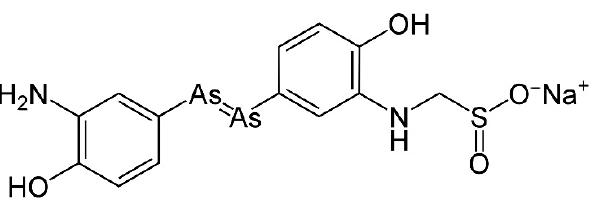
Figure 5. Chemical structure of Neosalvarsan ® . As in the case of Salvarsan ® , this formal structure bearing an arsenic-arsenic double bond is incorrect. Indeed, it is a mixture of differently-sized rings with arsenic-arsenic single bonds.